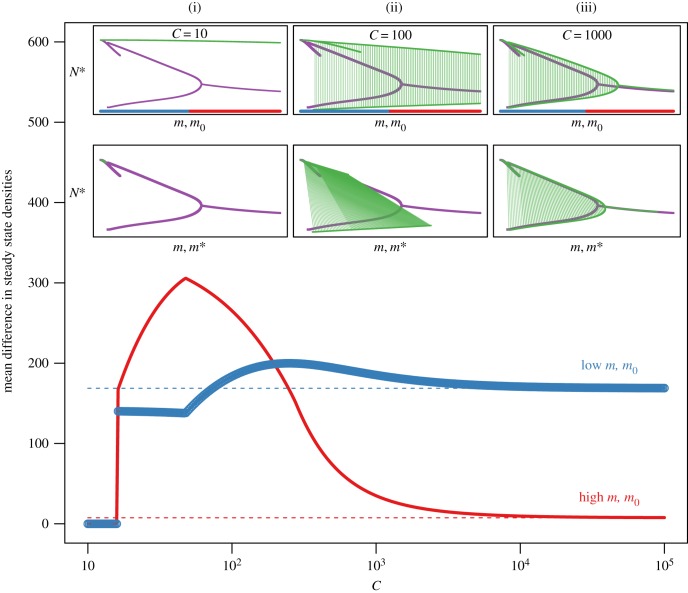
Comparison of steady-state population densities for the constant straying model and density-dependent straying model. Inset: steady-state densities for the constant straying model (purple) and density-dependent straying model (green) for different strengths of collective behaviour. Low C corresponds to strong effects of collective behaviour. The top row shows steady-state densities as a function of individual straying m0; the bottom row shows steady-state densities as a function of straying at the steady state m*. Vertical green lines link paired subordinate and dominant population densities. Main: The absolute difference in steady-state densities averaged across intervals of low straying (0 < m, m0 < 0.25; blue) and high straying (0.25 < m, m0 < 0.5; red). Horizontal dashed lines correspond to the mean absolute differences in steady-state densities for low (blue) and high (red) density-independent straying. As , mean absolute differences in steady-state densities become equivalent.